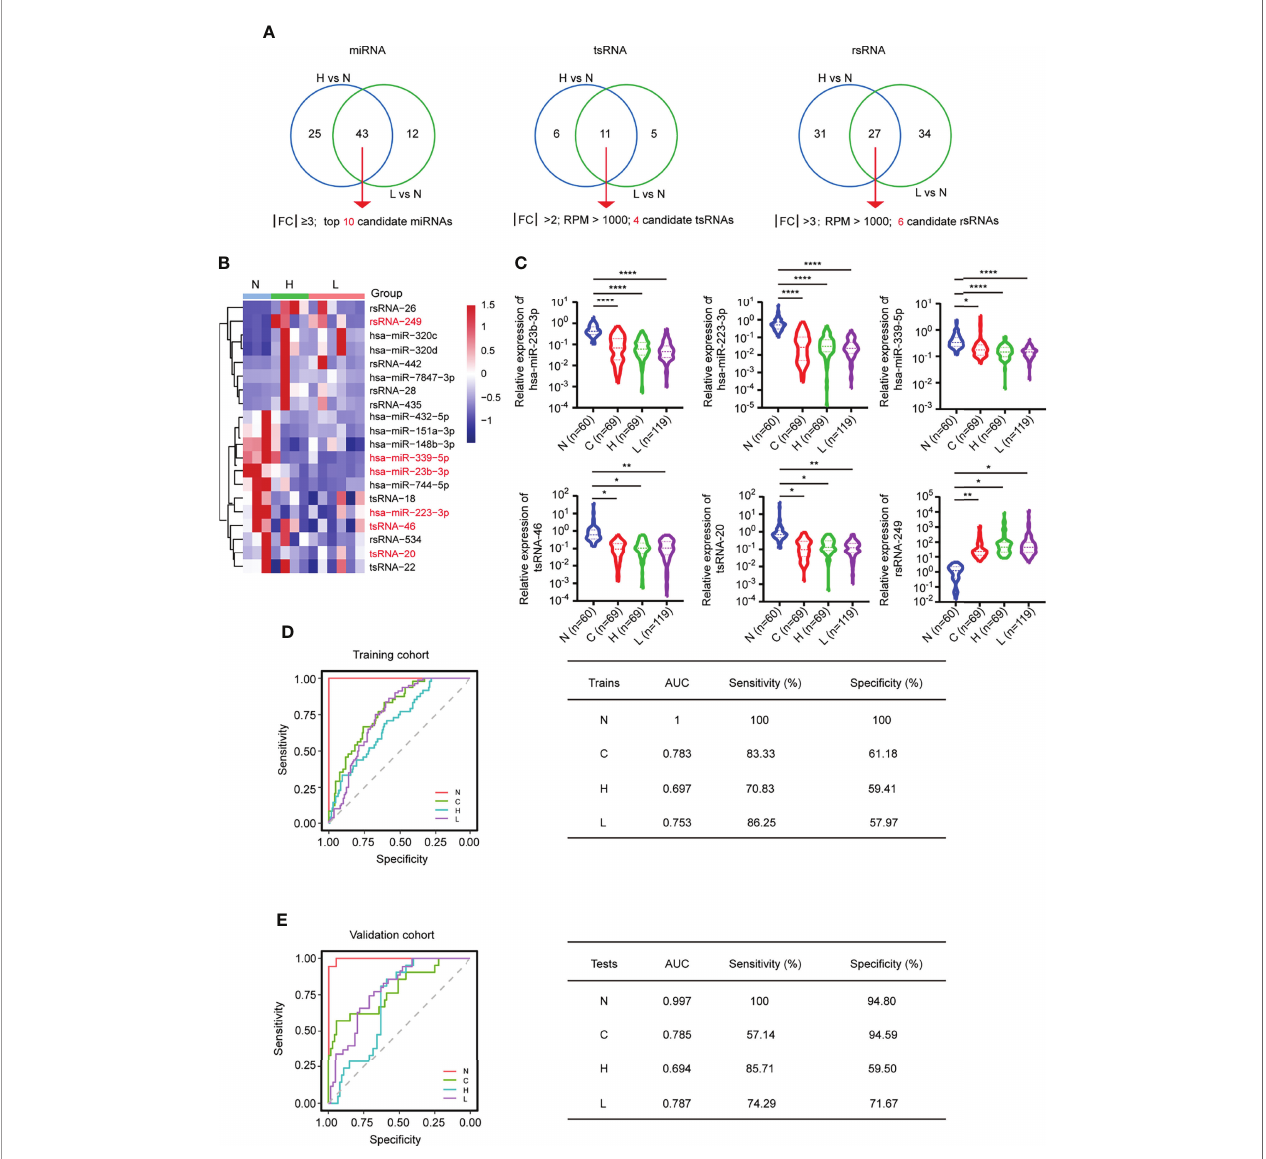
FIGURE 5 | MTR-RNA signature in predicting the validation set. (A) The Venn diagram showed the signi fi cantly differentially expressed sncRNAs between the comparison groups H vs. N and L vs. N. (B) Heatmap presenting sncRNA species in the MTR-RNA signature for the discovery set. (C) RT-qPCR analyses of exosomal hsa-miR-23b-3p, hsa-miR-223b-3p, hsa-miR-339-5p, tsRNA-20, tsRNA-46, and rsRNA-249 in the four groups (N = 60, C = 69, H = 69, and L = 115). Data are represented as mean ± SEM. * P < 0.05, ** P < 0.01 and **** P < 0.001. (D, E) ROC curve for MTR-RNA index used to distinguish ACLF cases from healthy controls and HBV- fl are cases from healthy controls of the training set (D) and the validation set, respectively (E) . The left represented the ROC curve. The right represented the model assessment. AUC, area under the ROC